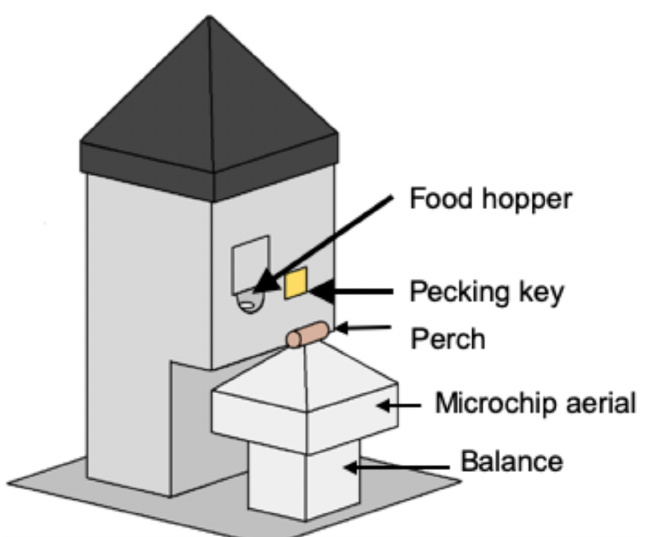
Figure 1. Diagram of a single social foraging system station. The wooden perch was 3.7 cm long and was mounted 22.0 cm above the base of the SFS and 8.0 cm from the hopper entrance. The pecking key was a 3.5-cm square of clear Perspex, hinged from the top and illuminated from behind with an array of LEDs. The food hopper was accessed via a 4 cm-wide aperture in the front panel of the SFS located to the left of the pecking